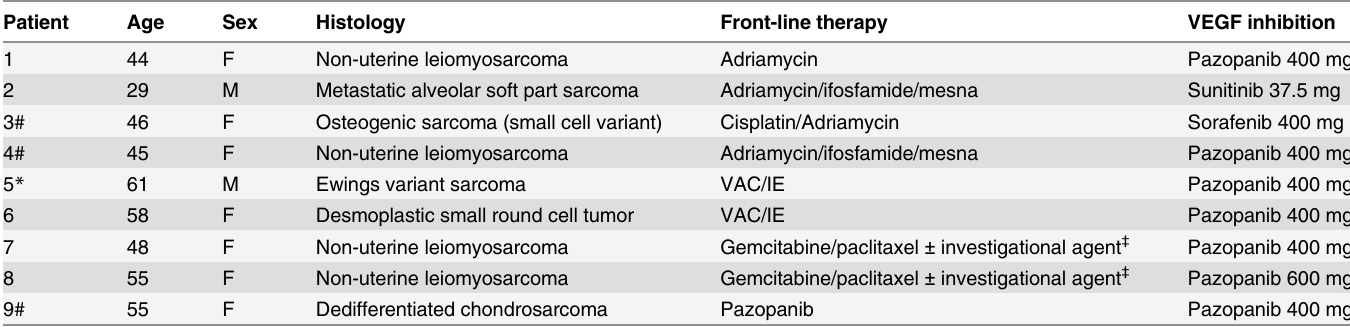
Table 1. Patient characteristics and treatments.